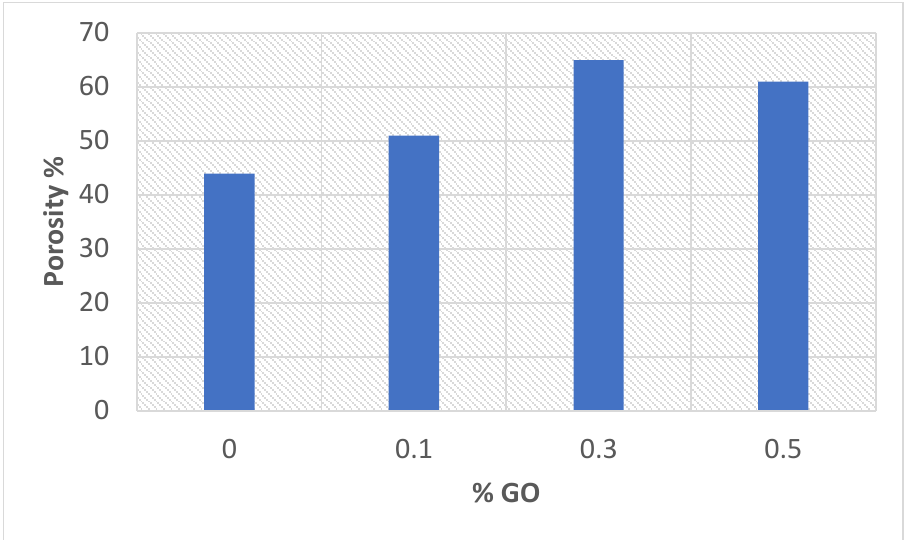
Figure 6. The % porosity as function of % GO incorporated in the prepared membrane.